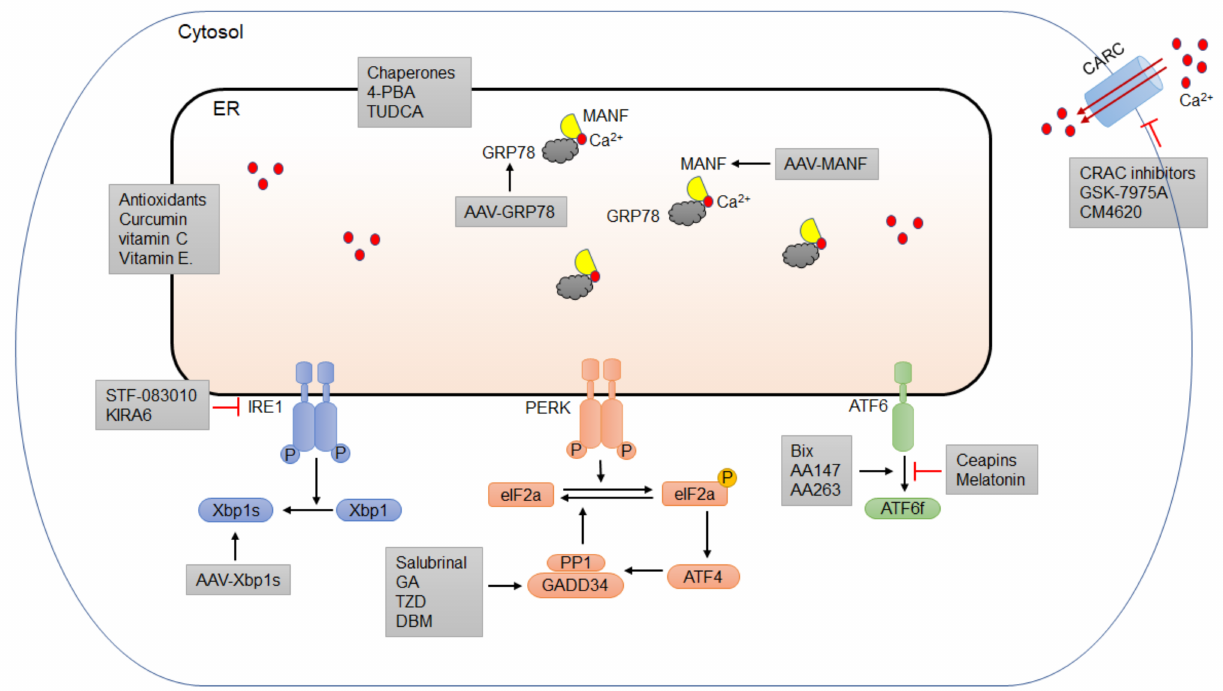
Figure 3. Potential pharmacological intervention for alcoholic pancreatitis targeting ER